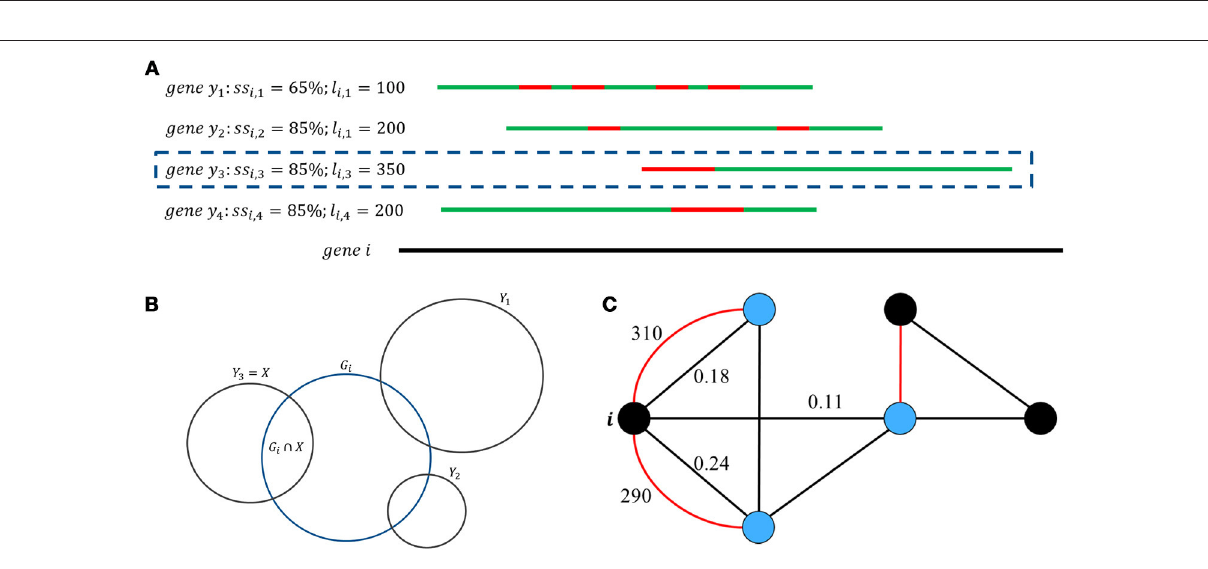
FIGURE 2 | Genomic, transcriptomic, and network feature development. (A) Genes with significant similarity are displayed, with D 1 being the maximum value of ss i , y * l i , y . In this situation, genes y 2 , y 3 , & y 4 all have the same ss i value, but gene y 3 has a longer consecutive string of matching base pairs ( l i ) than the other values, making it the more similar genomic location. (B) Graphical representation of the sets of reads aligned to each gene. D 2 is the largest overlapping proportion of shared ambiguous or multi-mapped reads between the target gene, gene i , and all other genomic locations that have at least one read potentially aligned to both locations. (C) This graph displays the significant interactions of gene i with other genomic locations. Each node represents a genomic location, with the red edges representing sequence similarity scores and black edges representing multi-mapping proportions. In this situation, D 1 = 310, D 2 = 0.24, and D 3 = ( 3 + 1 ) = 0.602. proportion of shared MMRs between the gene of interest and another gene. In other words, D 2 = | G i ∩ X | , where | G i | G i = { all reads aligned to gene i } and X = | G i ∩ Y |